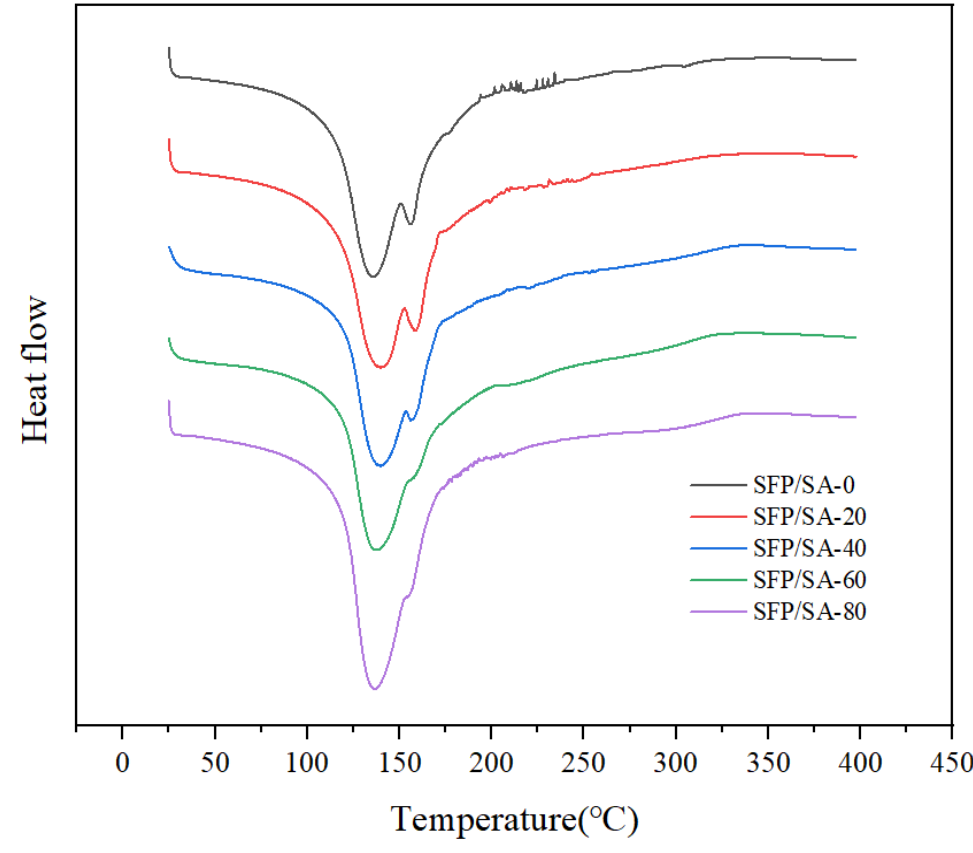
Figure 5. DSC curves of SFP/SA-0 (black line), SFP/SA-20 (red line), SFP/SA-40 (blue line), SFP/SA- 60 (green line) and SFP/SA-80 (purple line) from 25 – 400 °C at a heating rate of 20 °C/min under N 2 flow.